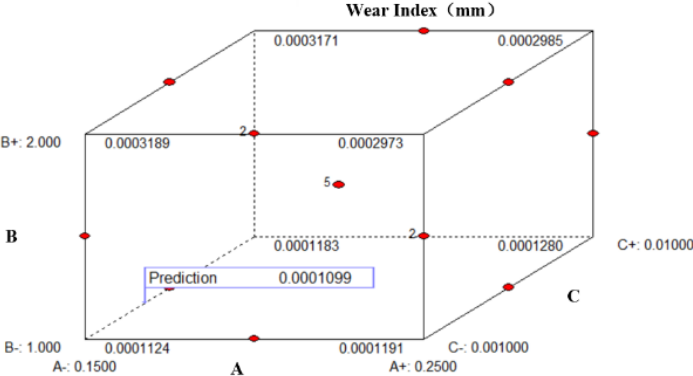
Figure 16. Optimization results of the regression model.